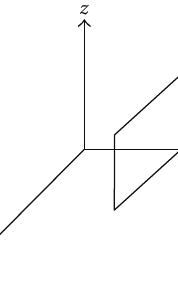
Figure 5: PEC square plate with length of 100m.